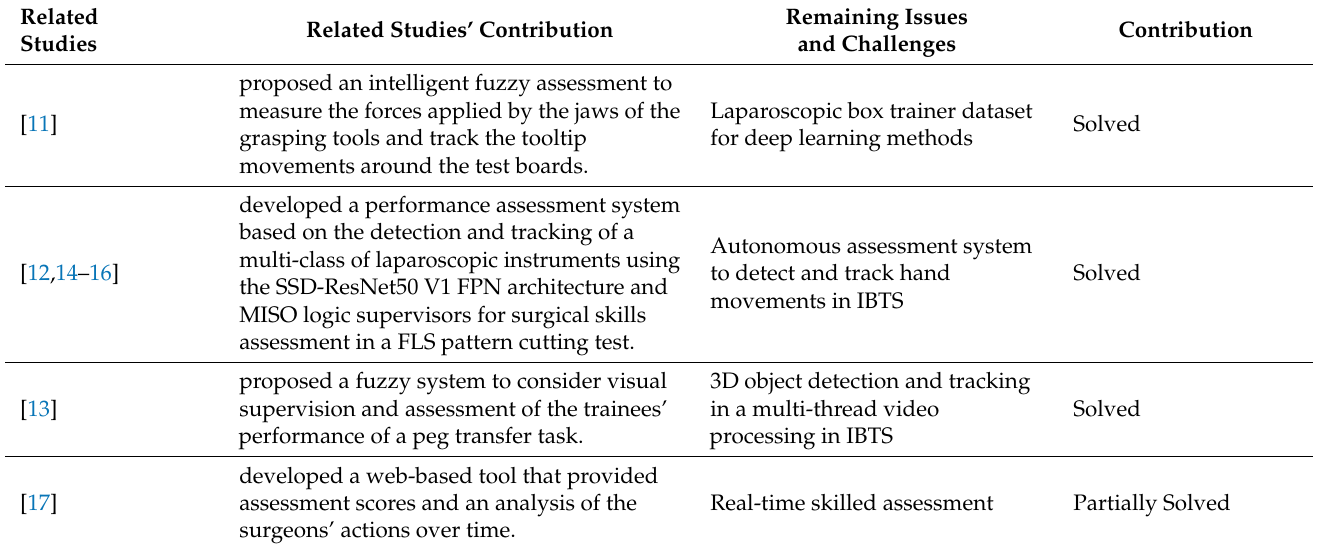
Table 1. Summary of the related works and the contribution of the current